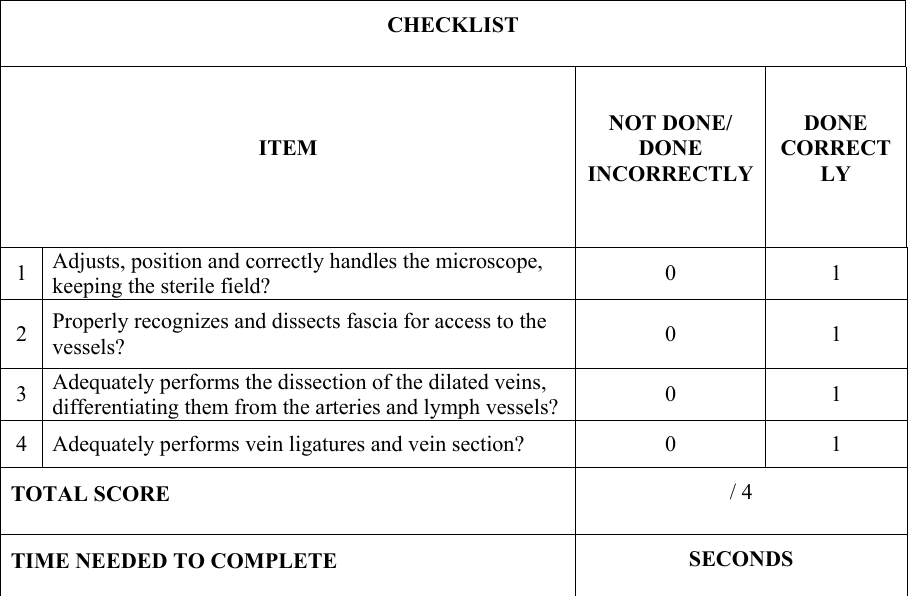
Table 1 - Final version of the task-specific checklist for microsurgical varicocelectomy.